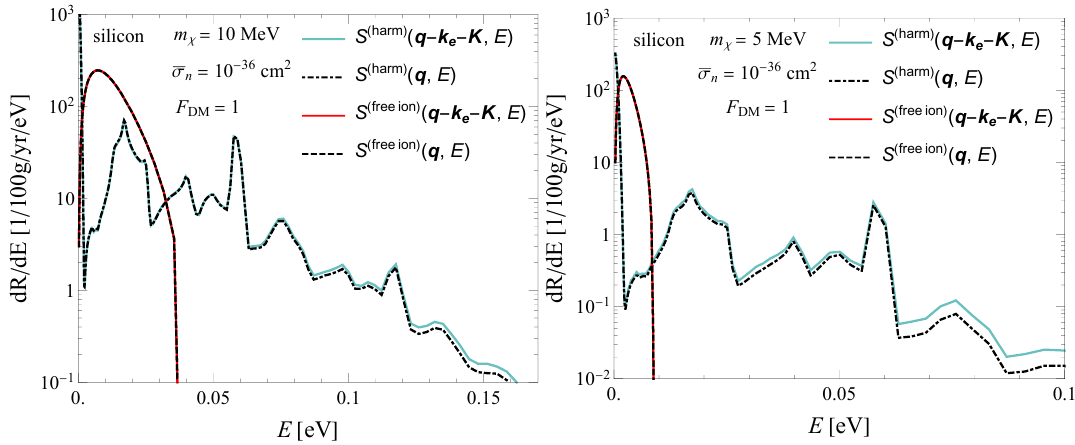
Figure 7. We show the differential rate dR/dE , measurable by next-generation detectors, as function of energy E deposited to the lattice, contrasting the harmonic dynamic structure factor with the free-ion approximation for DM with masses m χ = 10 MeV ( left panel ) and m χ = 5 MeV ( right panel ). We set the reference cross section to ¯ σ n = 10 − 36 cm 2 and the minimum electron energy to ω min = 5 eV. The harmonic dynamic structure factor accurately captures the non-zero probability of phonon excitations energies above the allowed threshold in the free-ion approximation, illustrating the break-down of the free-ion approximation. Neglecting the electron momentum in the dynamic structure function results only in small differences even for the lightest DM, m χ = 5 MeV, where the electron momentum is of order of the total momentum transfer. Consistent with figure 3 we convolve the elastic scatterings with no energy deposition S (harm) = δ ( E ) with a Gaussian to 0 illustrate the shift from phonon depositions to elastic scatterings off the